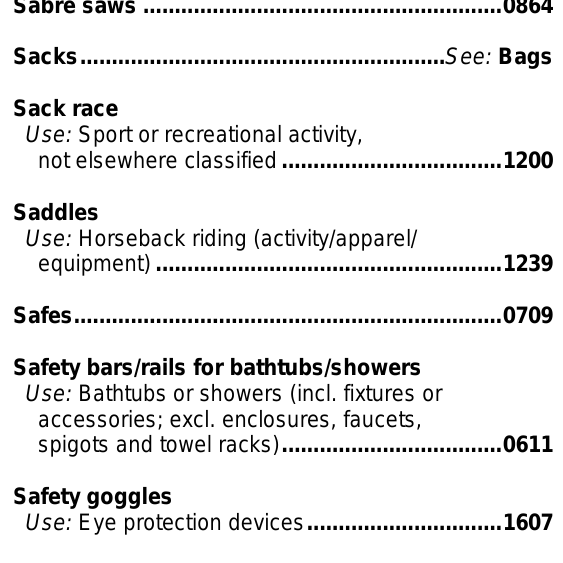
Safety bars/rails for bathtubs/showers Use: Bathtubs or showers (incl. fixtures or accessories; excl. enclosures, faucets,